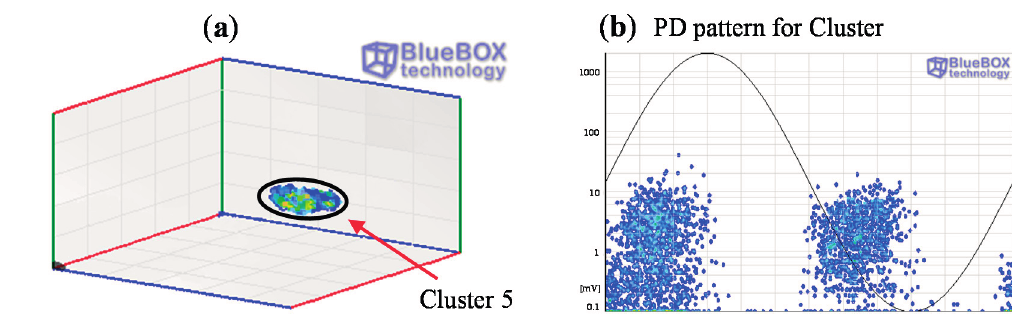
Figure 24. ( a ) Classification of PD pulses positioned in D; ( b ) PRPD pattern for the source positioned in